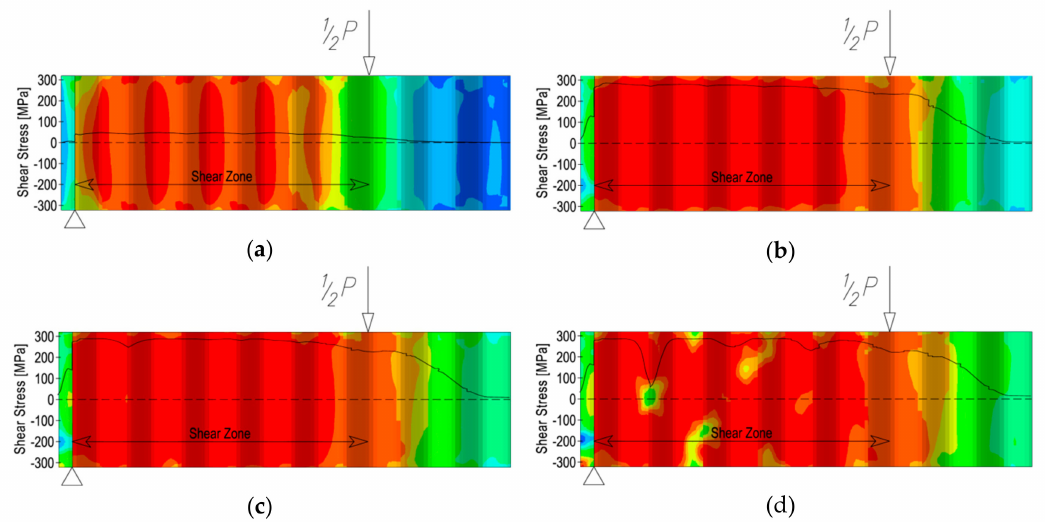
Figure 16. Shear stress distribution in the sinusoidal web of the steel beam with rising load: ( a ) at the beginning of loading; ( b ) before buckling; ( c ) upon formation of the first plastic hinge; ( d ) after